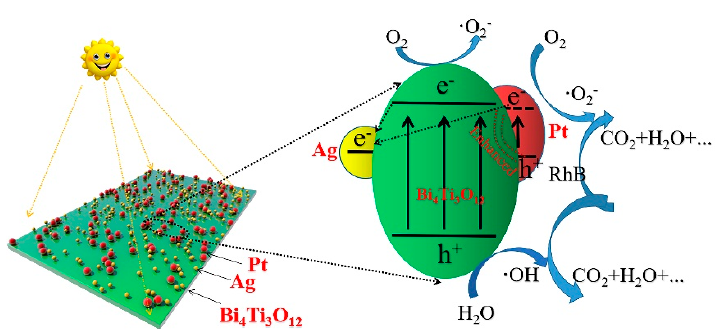
Figure 13. Proposed photocatalytic mechanism for degradation of RhB using as-prepared AgPt/Bi 4 Ti 3 O 12 composite photocatalysts.